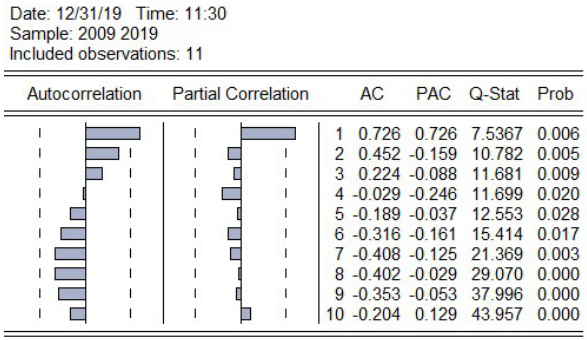
Fig. 4 Autocorrelation and partial autocorrelation after second-order